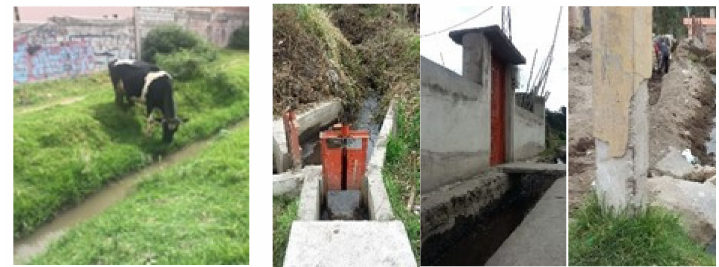
Figure 3. Irrigation